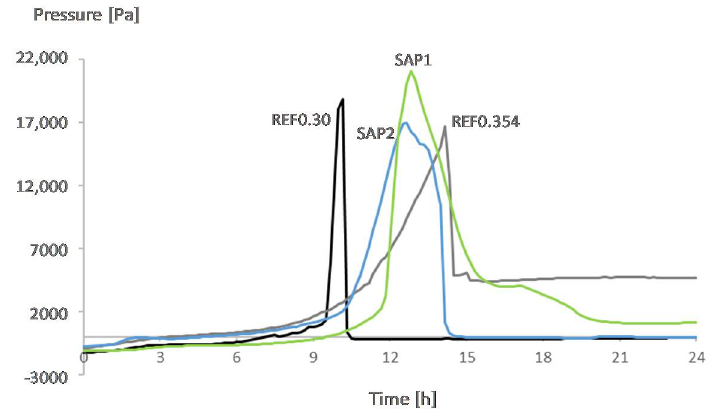
Figure 6. Development of the capillary pressure over time for all mixtures.